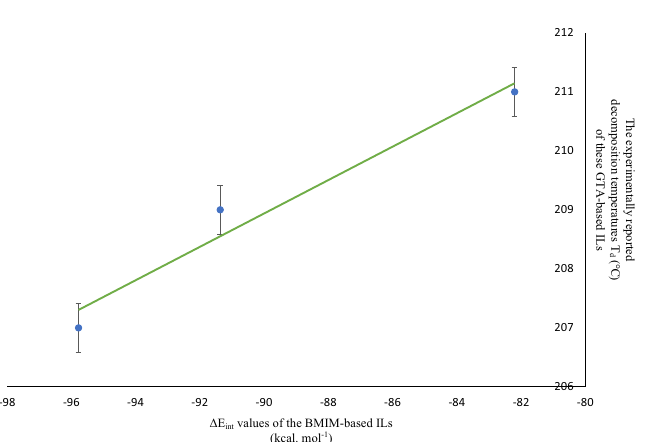
Figure 11. The experimentally reported decomposition temperatures of ionic liquids including (GTA)(Trp), (GTA)(His) and (GTA)(Tyr) ( ℃ ) against their calculated ΔE int values (kcal. mol -1 ) obtained at the B3LYP/6- 311++G(d,p) level, (error bar % =